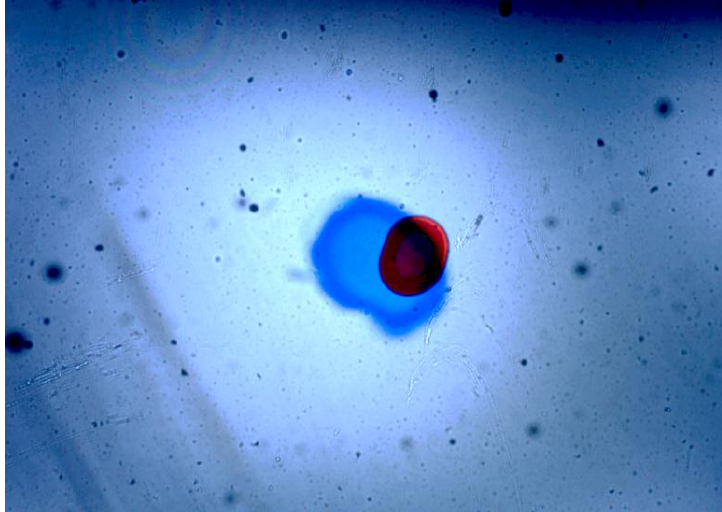
Figure 24. Sensor mounting the BK7 glass. Sample is Fuch Renolyn (clear fluid) and the flowing speed is approximately 1.5 L/min. Different particles and fibers are present in the image. Table 4. Particle detection and classification execution time using the different CPUs